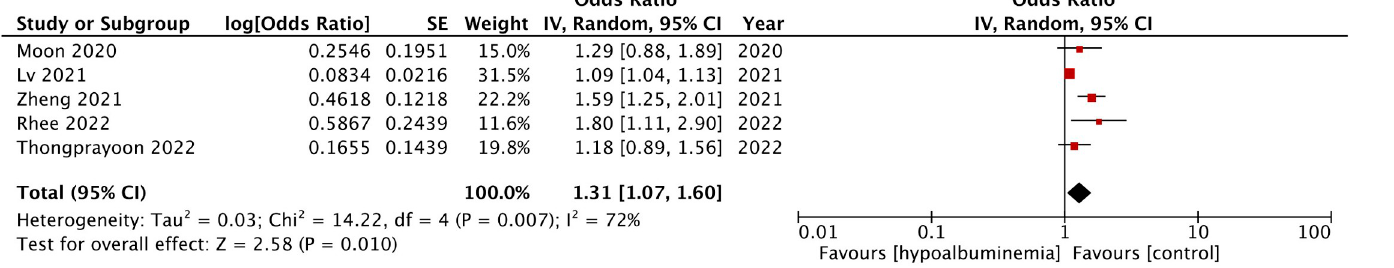
PLOS ONE | https://doi.org/10.1371/journal.pone.0283623 March 30,